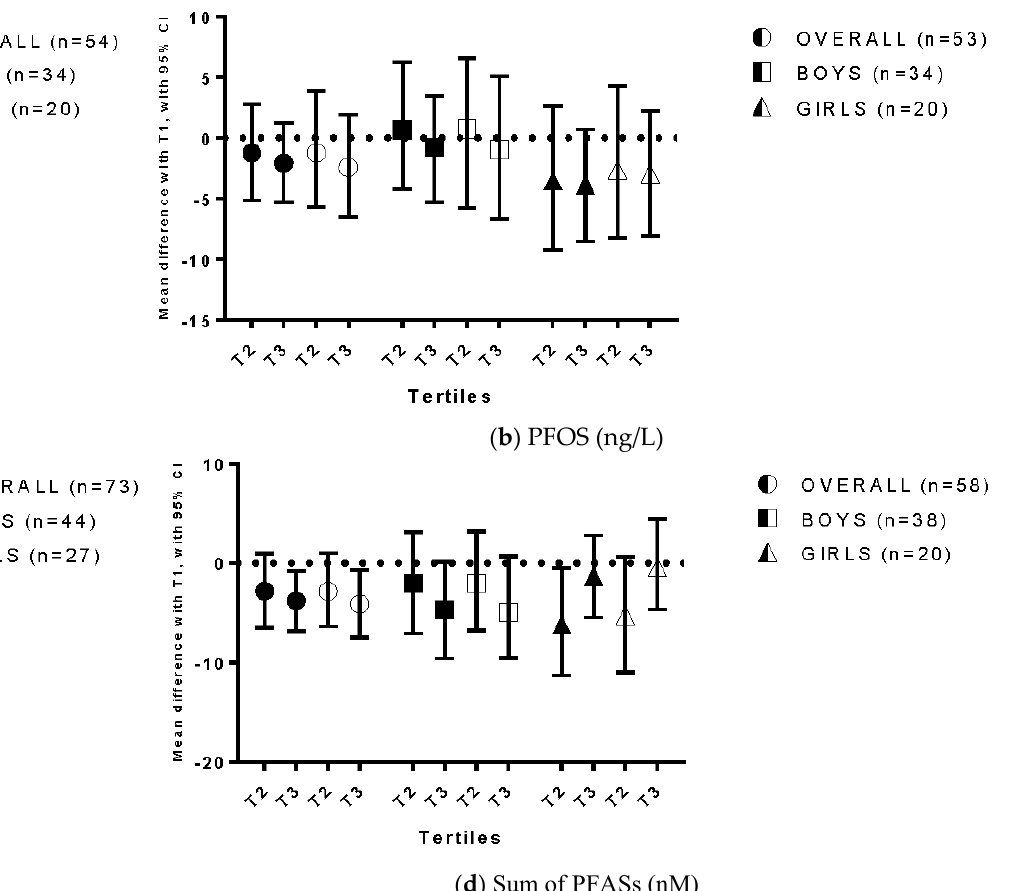
Figure 3. Exposure to perfluoroalkyl substances and scores on the Externalizing Behavior Scale of the Child Behavior Checklist 1.5–5. ( a ) PFOA (ng/L); ( b ) PFOS (ng/L); ( c ) Sum of PFASs (ng/L); ( d ) Sum of PFASs (nM). The mean difference in ADHD scores between tertiles of exposure is reported, with T1 as a reference category. Filled symbols represent results from crude analyses, while empty symbols represent results from adjusted analyses.